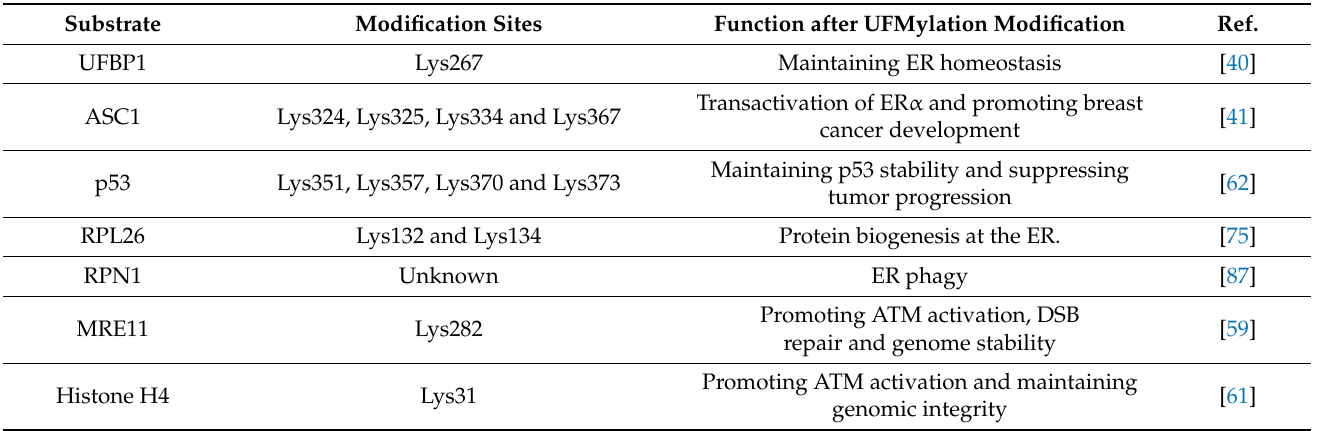
Table 2. Summary of the identified UFMylated